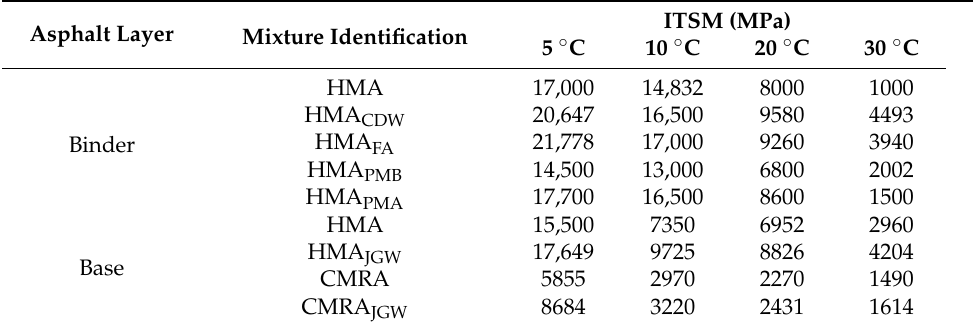
Table 5. Indirect tensile stiffness modulus results at 5, 10, 20, and 30 ◦ C for the asphalt mixtures under